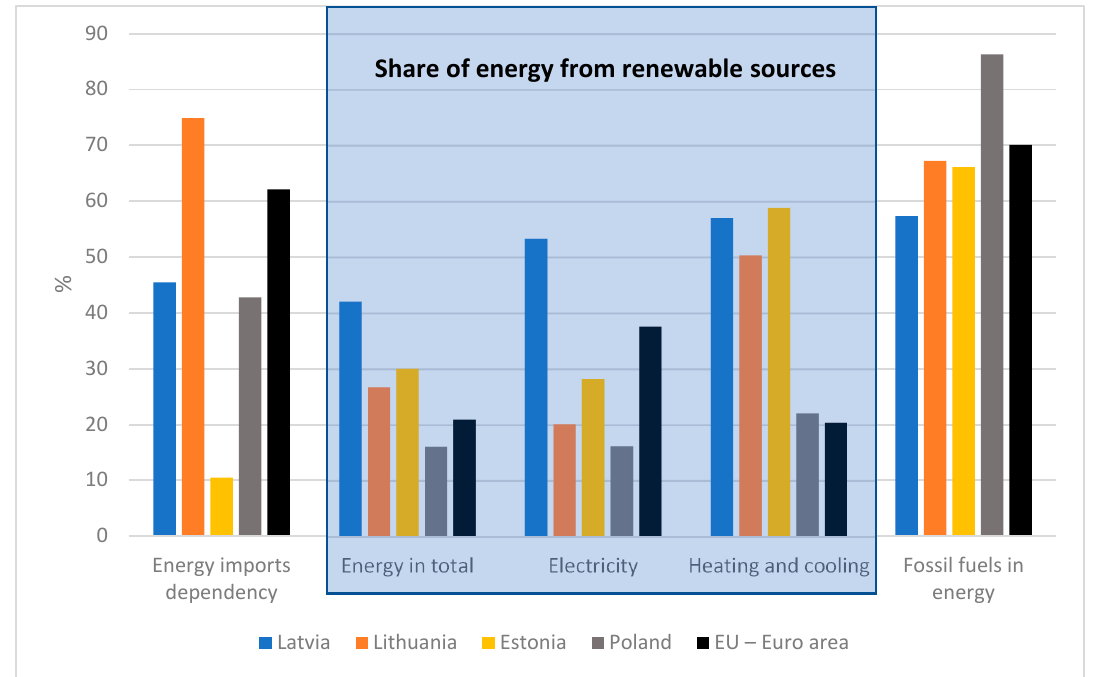
Figure 1. Dependence on energy imports and share of energy from renewable sources and fossil fuels in Baltic countries, Poland and the Euro area in 2020 (after: [6]). (The presented data also include Poland, which, like the Baltic countries, joined the EU in 2004, but previously belonged to the Eastern Bloc and thus to the economic zone of the Council for Mutual Economic Assistance).